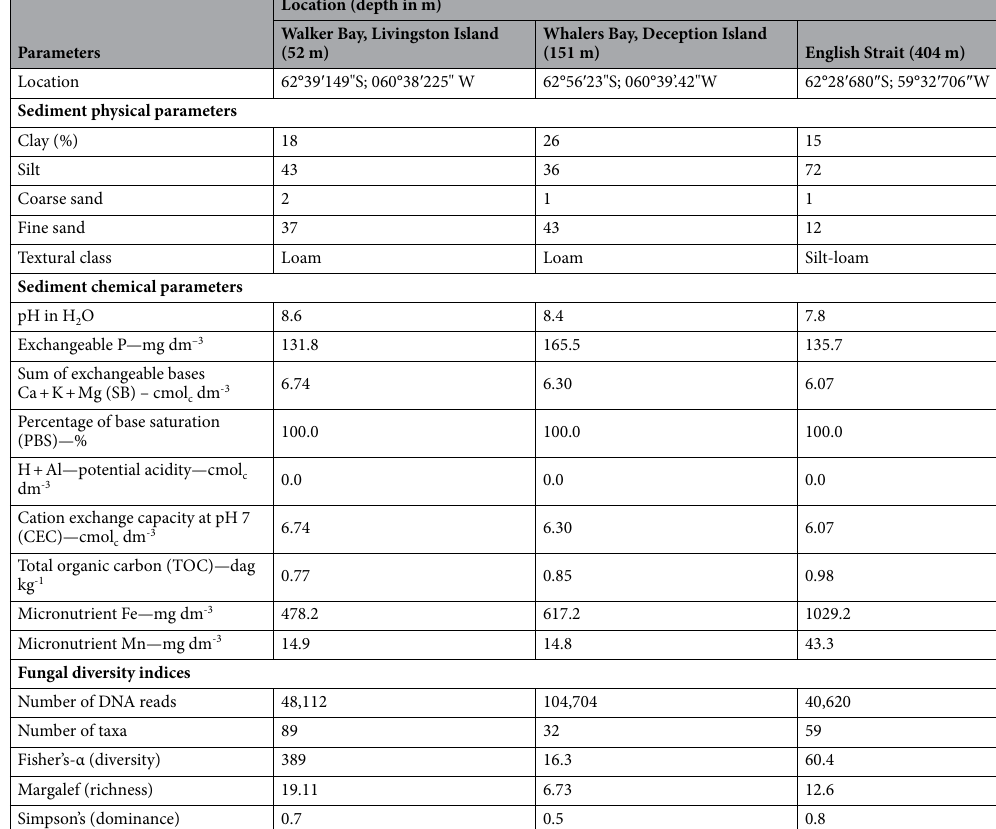
Table 1. Sampling locations, characteristics, sediment physicochemical data and diversity indices of fungal assemblages detected in the three marine sediments analysed from the South Shetland Islands, maritime